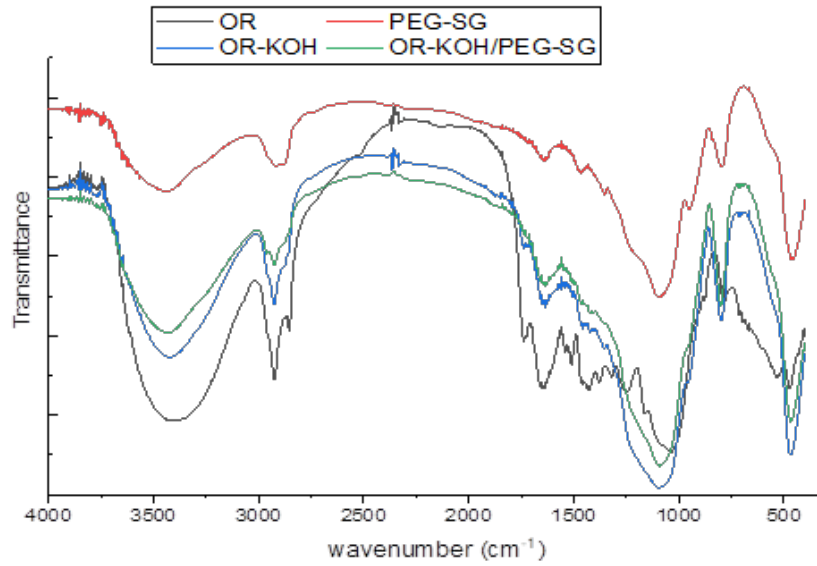
Figure 2. IR spectra of OR, OR-KOH, PEG-SG, and OR-KOH/PEG-SG.